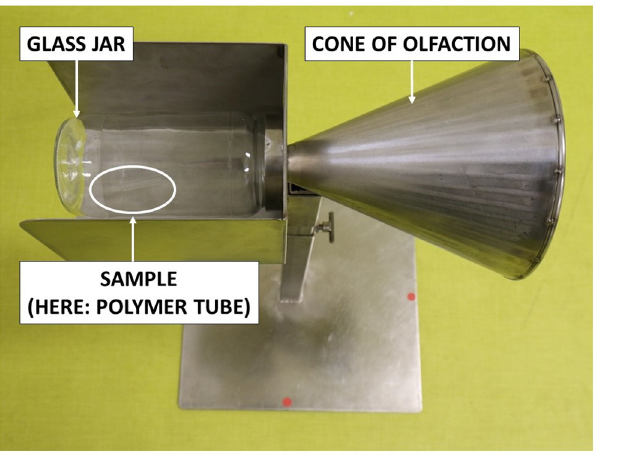
Fig 5. Testing equipment.